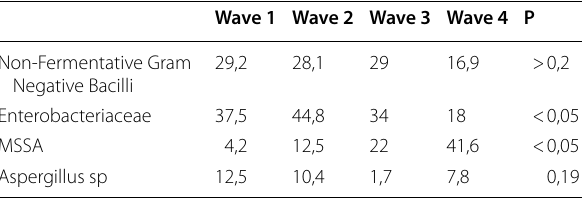
Table 2. Microorganisms isolated in blood cultures during the